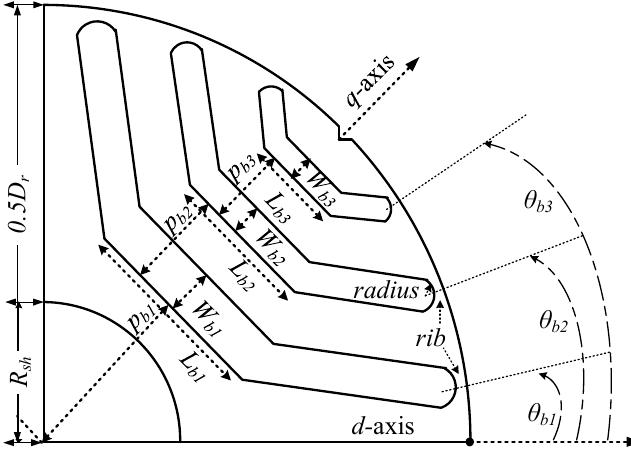
Figure 1. Rotor geometry of one pole of synchronous reluctance machines (SynRM).